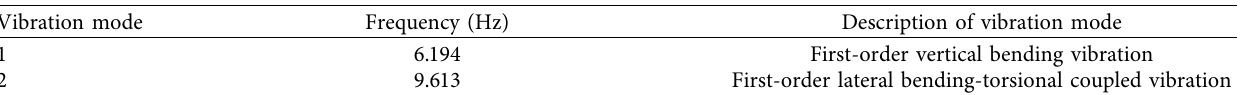
Figure 11: Experimental strain value at middle span. (a) 10km/h. (b) 20km/h. (c) 30km/h. (d) Brake at 10km/h. Table 3: Modal